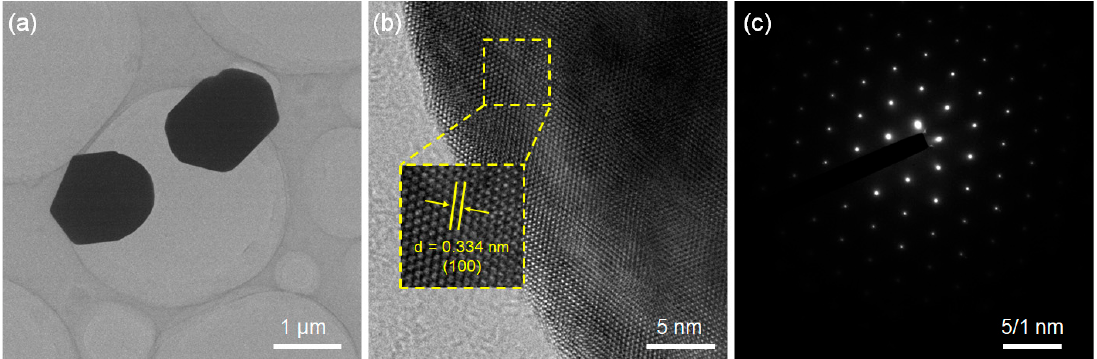
Figure 3. Results of the GOS:Tb, 0.08F scintillators. ( a ) TEM image, ( b ) HR-TEM image and ( c ) SAED pattern .